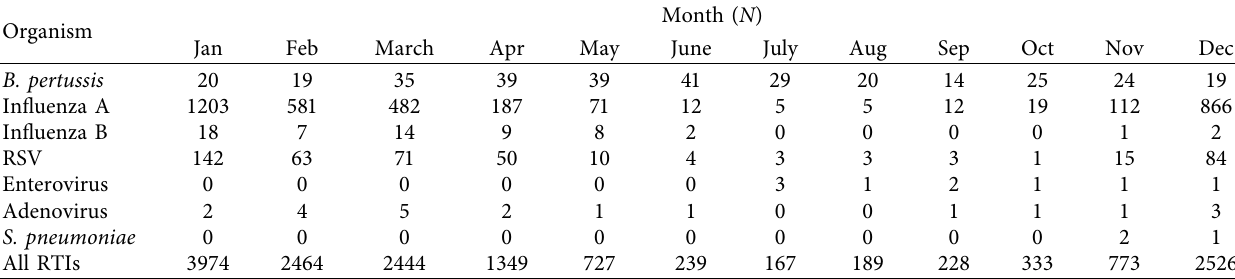
Figure 1: Incidence rates of major causes of respiratory tract infection-related hospitalization (2011–2016) stratified by age, West Bank. (a) B. pertussis ; (b) enterovirus; (c) influenza A; (d) influenza B; (e) RSV; (f) adenovirus. Table 4: Frequency of confirmed respiratory tract infection-related hospitalization stratified by the month of